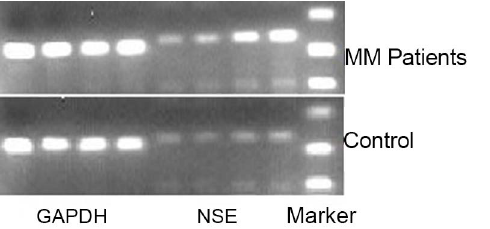
Figure 2. RT-PCR product electrophoresis for GAPDH (control and NSE) in previously untreated MM patients and